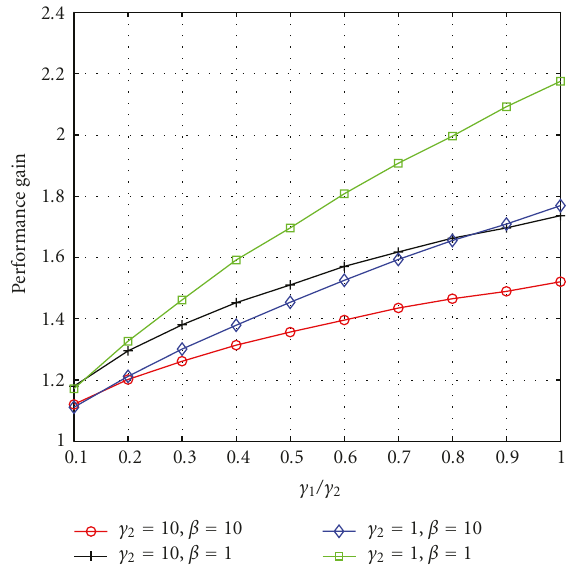
Figure 9: Performance gain by incorporating the source- destination